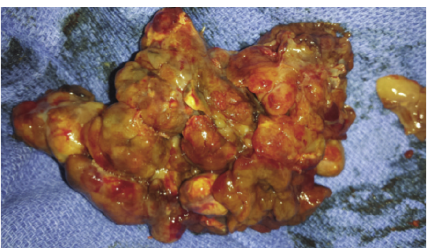
Figure 3: Macroscopic view of the cardiac metastatic melanoma surgically removed from the right